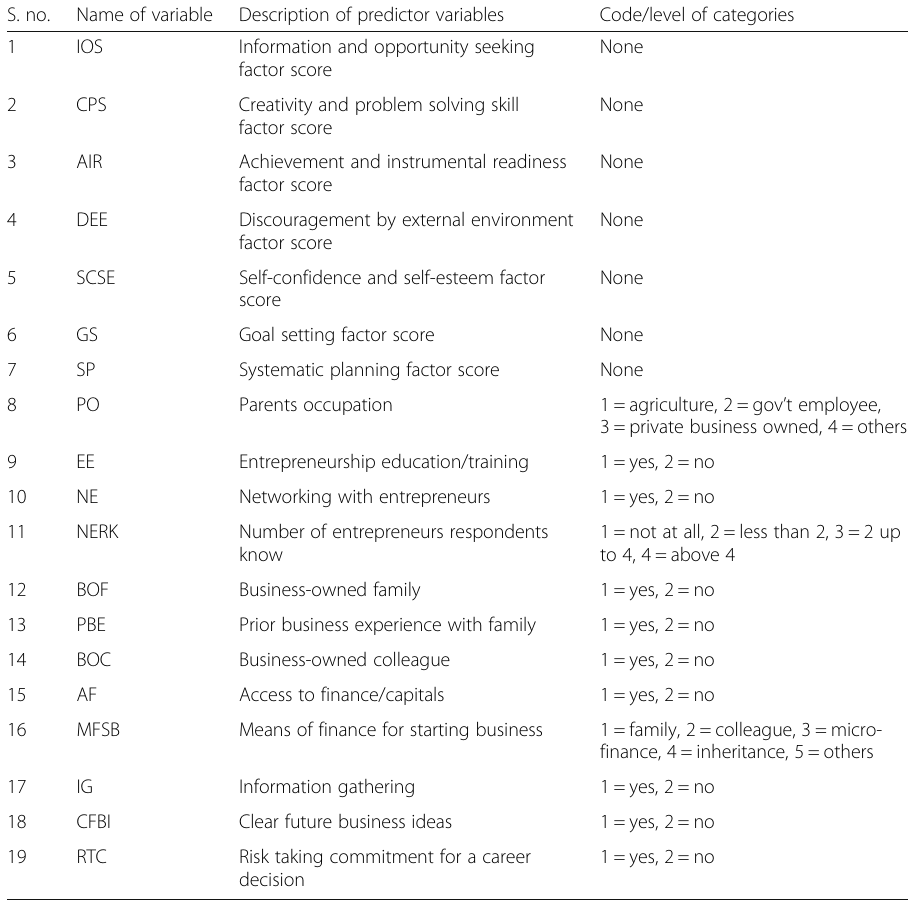
Table 1 List of independent variables (covariates) S.